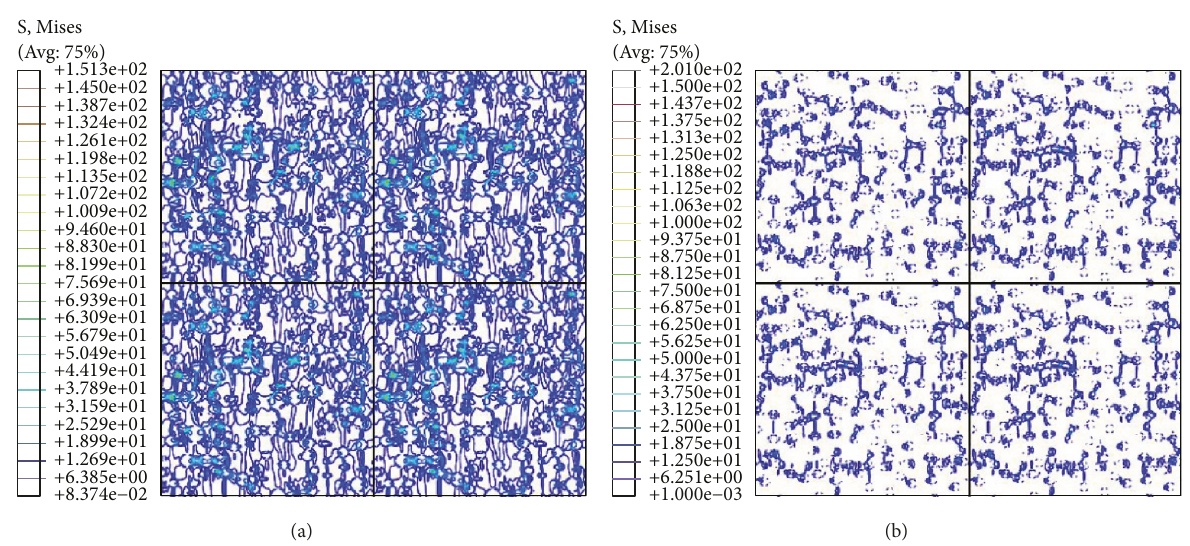
Figure 10: Distribution of Mises stress in two kinds of RVE models: (a) di ff erent particle size random model and (b) same particle size random model.